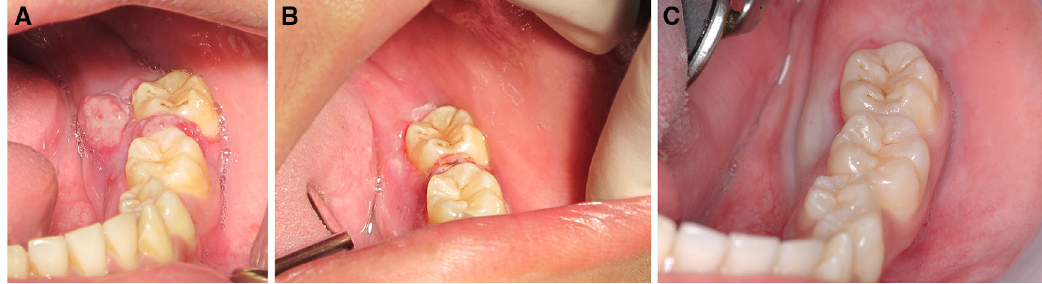
Figure 6. The clinical outcomes after interstitial-intralesional laser therapy. A. 2 weeks after the first therapy. B. 2 weeks after the second therapy. C. 3 weeks after the third